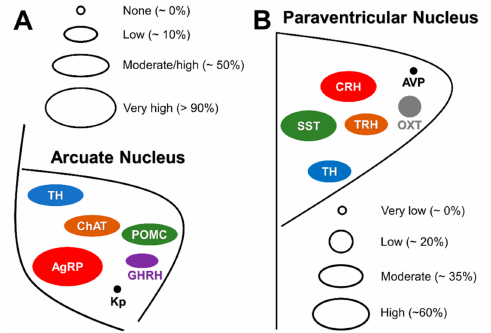
Figure 3. Neurochemical phenotype of GH-responsive neurons in the hypothalamic arcuate and paraventricular nuclei. ( A ) Scheme illustrating the approximate percentage of responsiveness to GH in arcuate nucleus neurons that express agouti-related peptide (AgRP), proopiomelanocortin (POMC), choline acetyltransferase (ChAT), tyrosine hydroxylase (TH), GH-releasing hormone (GHRH) and kisspeptins (Kp). ( B ) Scheme illustrating the approximate percentage of responsiveness to GH in hypothalamic paraventricular nucleus neurons that express somatostatin (SST), TH, corticotropin- releasing hormone (CRH), thyrotropin-releasing hormone (TRH), oxytocin (OXT) and vasopressin (AVP). The relative size of circles and ellipsoids indicates the approximate percentage of neurons in these nuclei which are responsive to